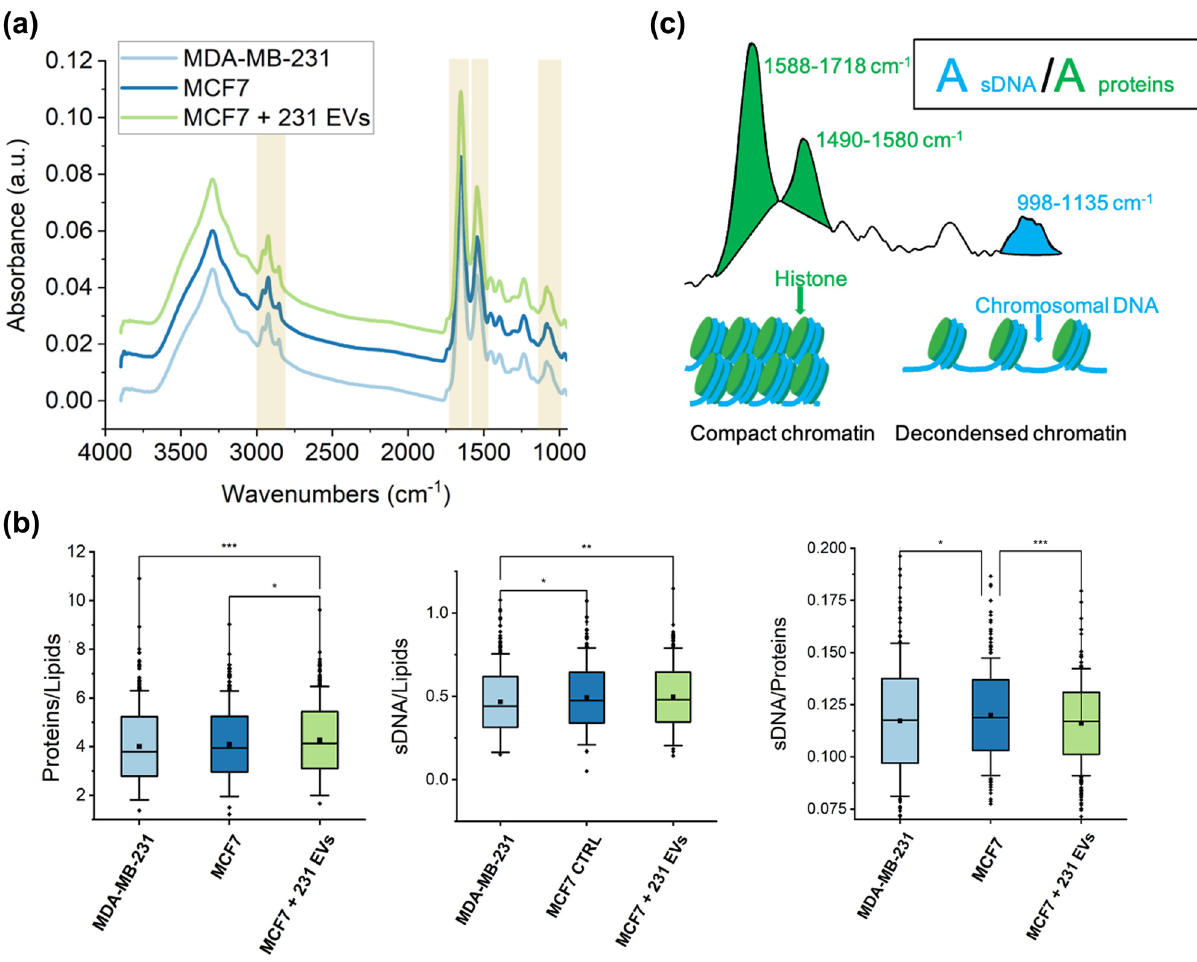
Figure 3: FTIR spectroscopy of MDA - MB - 231, MCF7, and 231_sEV - treated MCF7 cells. FTIR spectra of the average absorbance used for the calculation of di ff erent peak ratios ( a ) . Boxplots of the ratios obtained from the respective integrated area peaks ( Row b ) . The DNA - to - protein peak ratio is associated with the chromatin state at the single - cell level and a cartoon representing the compact or decondensed chromatin state ( c ) . The lower and the upper boundaries of the box represent the SD of the data; the ▫ symbol and the horizontal bar inside the box represent the mean and median, respectively. The signi fi cance of data di ff erences was established via ANOVA Tukey test ( * p < 0.05; ** p < 0.01; *** p < 0.001; **** p < 0.0001, respectively )